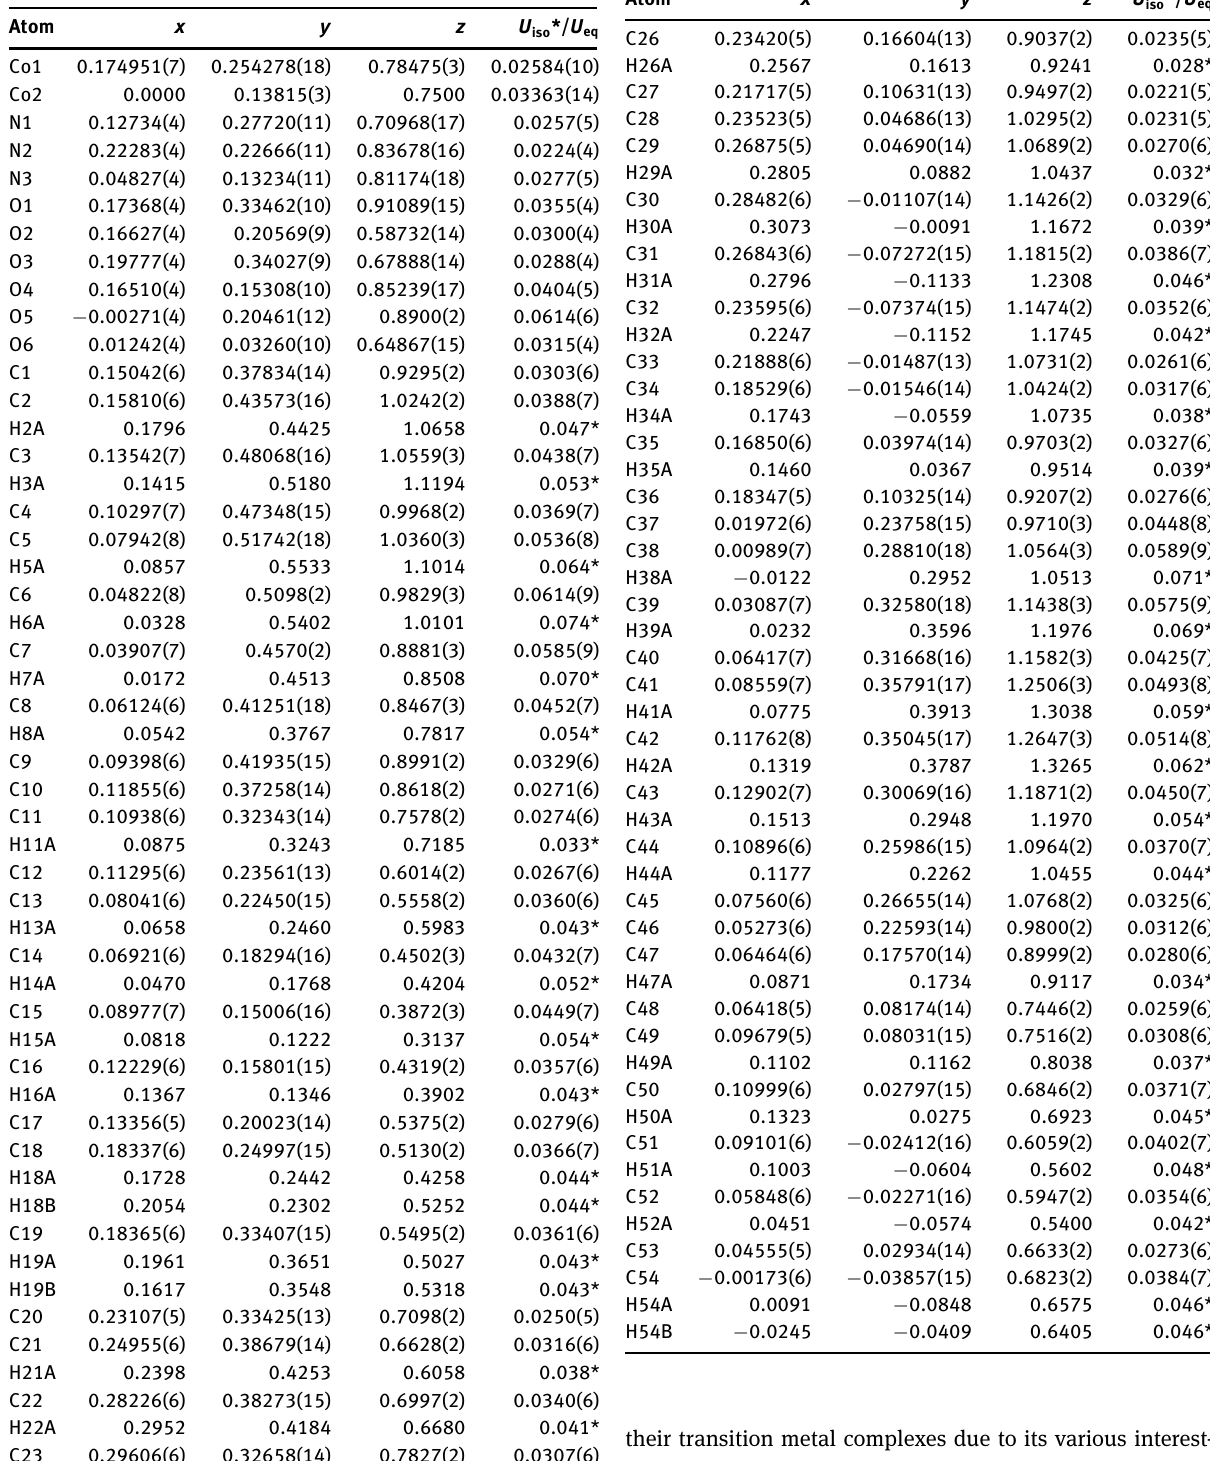
Table 2: Fractional atomic coordinates and isotropic or equivalent isotropic displacement parameters (Å 2